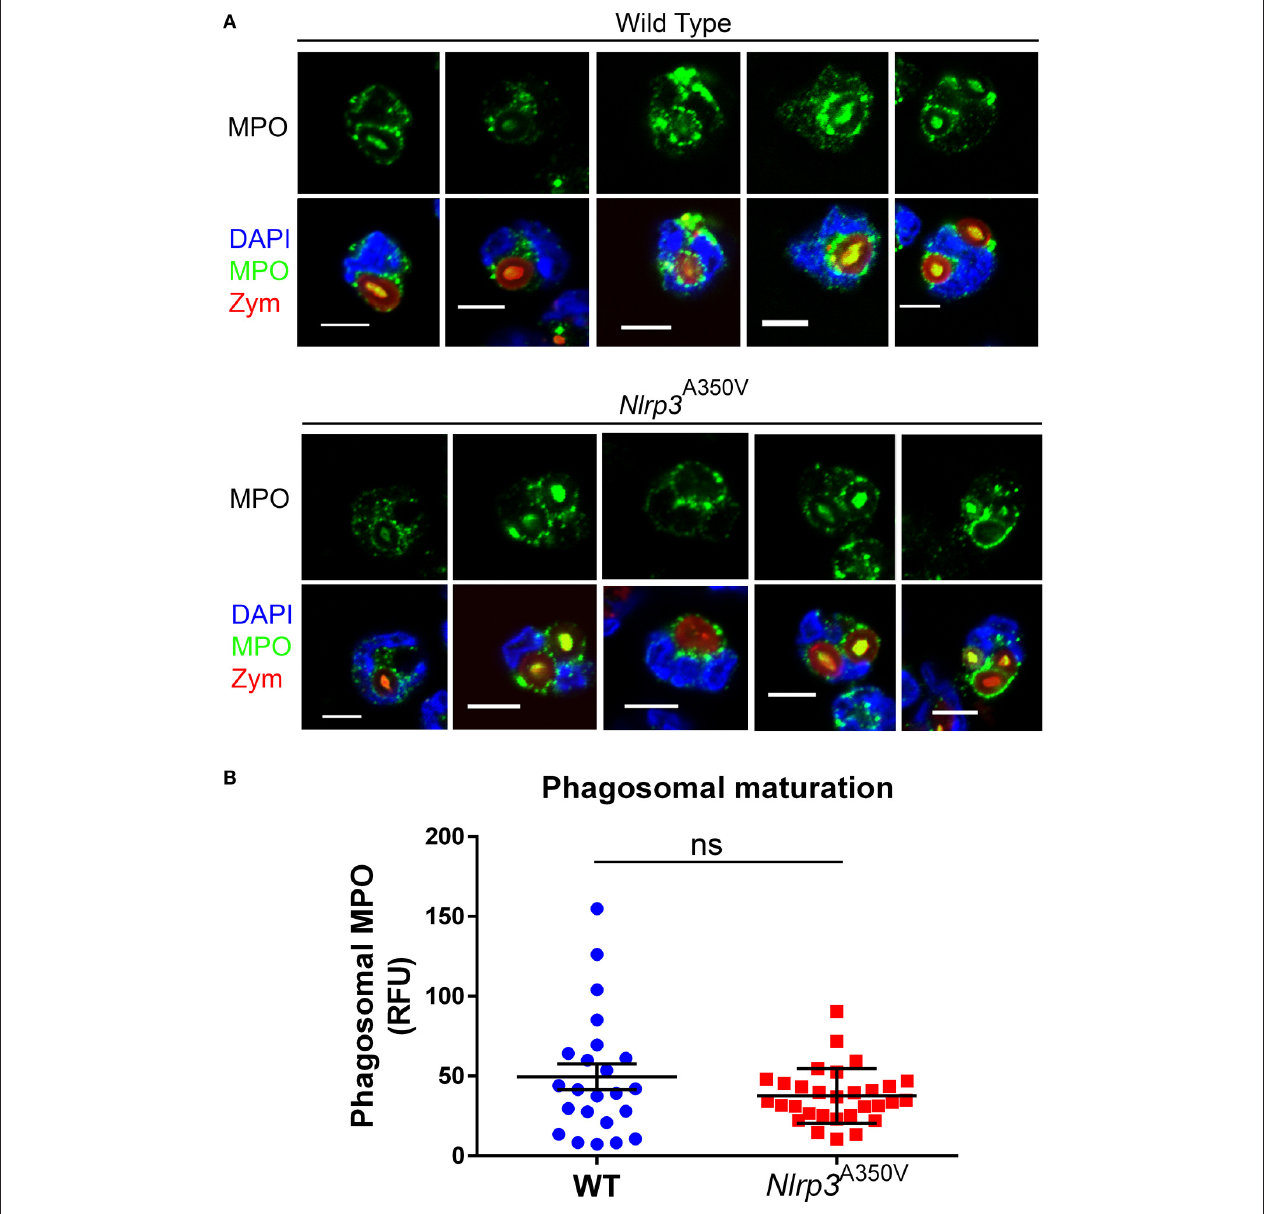
FIGURE 4 | The delivery of azurophilic granule cargo to the phagosome is not affected in Nlrp3 A350V MWS neutrophils. Isolated neutrophils were incubated in the presence of serum-opsonized Texas-Red zymosan for 30min, fixed and analyzed for the distribution of endogenous myeloperoxidase (green) by immunofluorescence microscopy. (A) , Representative images of five different phagocyting wild type and MWS mutant neutrophils are shown. (B) , Quantitative analysis of the relative fluorescence intensity surrounding each phagosome from 23 phagosomes from wild type cells and 30 phagosomes from MWS mutant cells. The bars represent the mean ± SEM. No significant differences between these two groups were observed (ns), using unpaired Student’s t